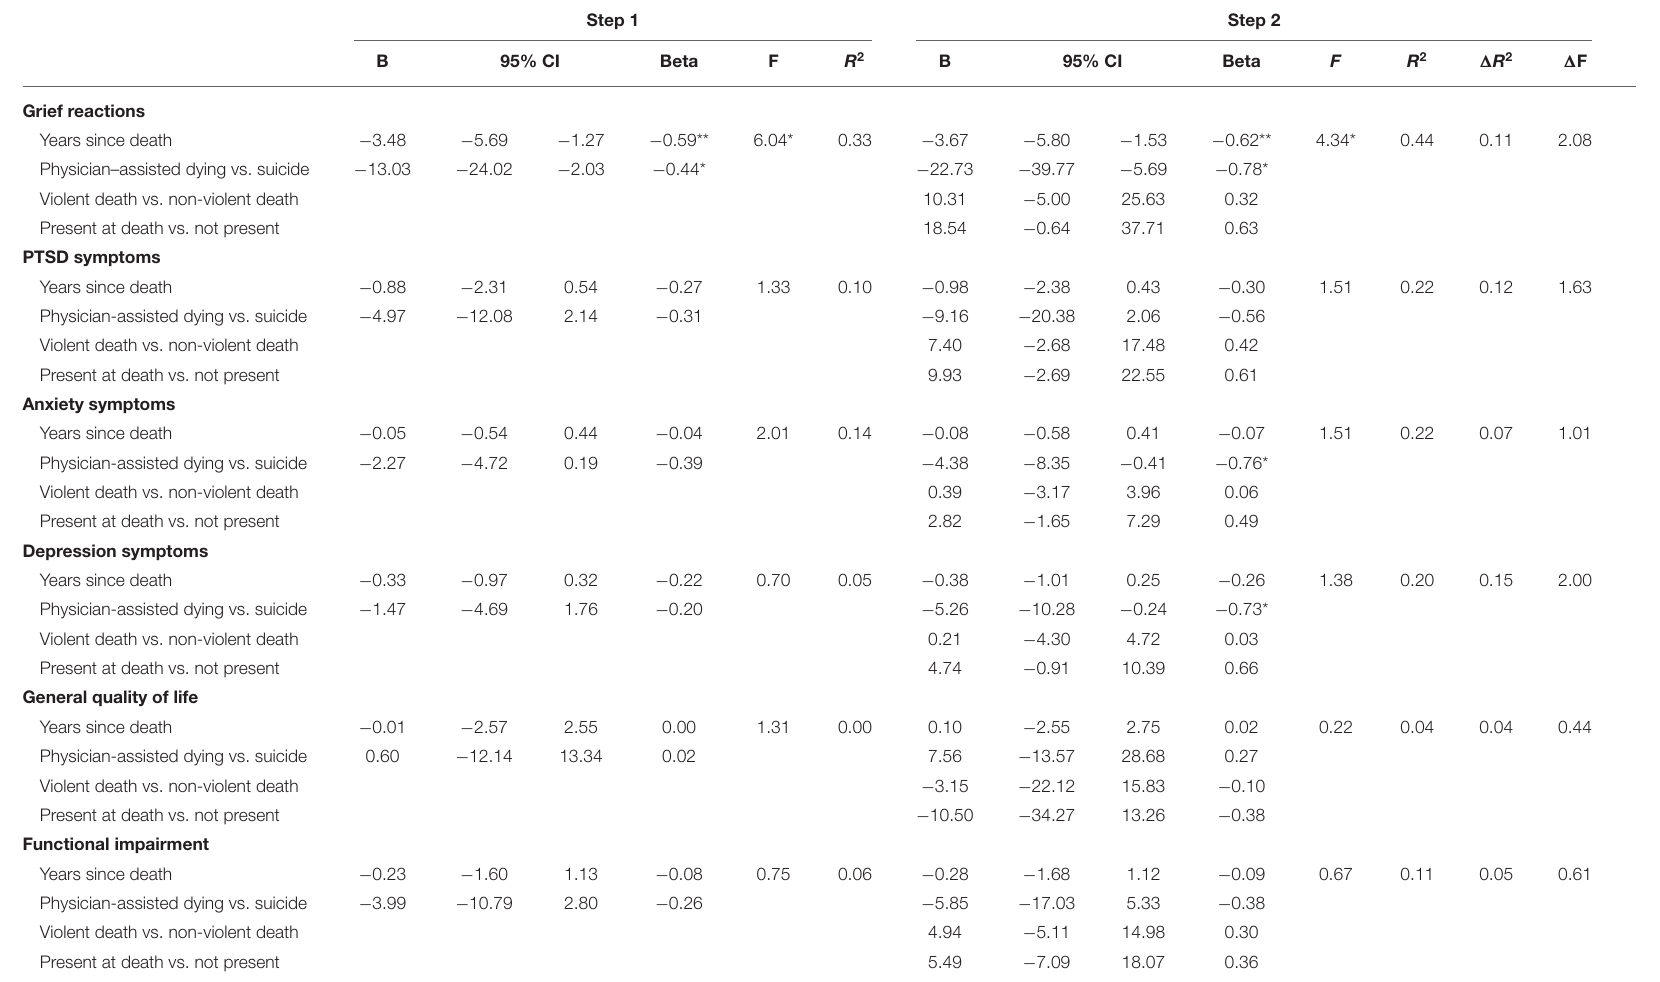
TABLE 7 | Multiple regressions predicting mental health outcomes based on mode of partner’s death and time since